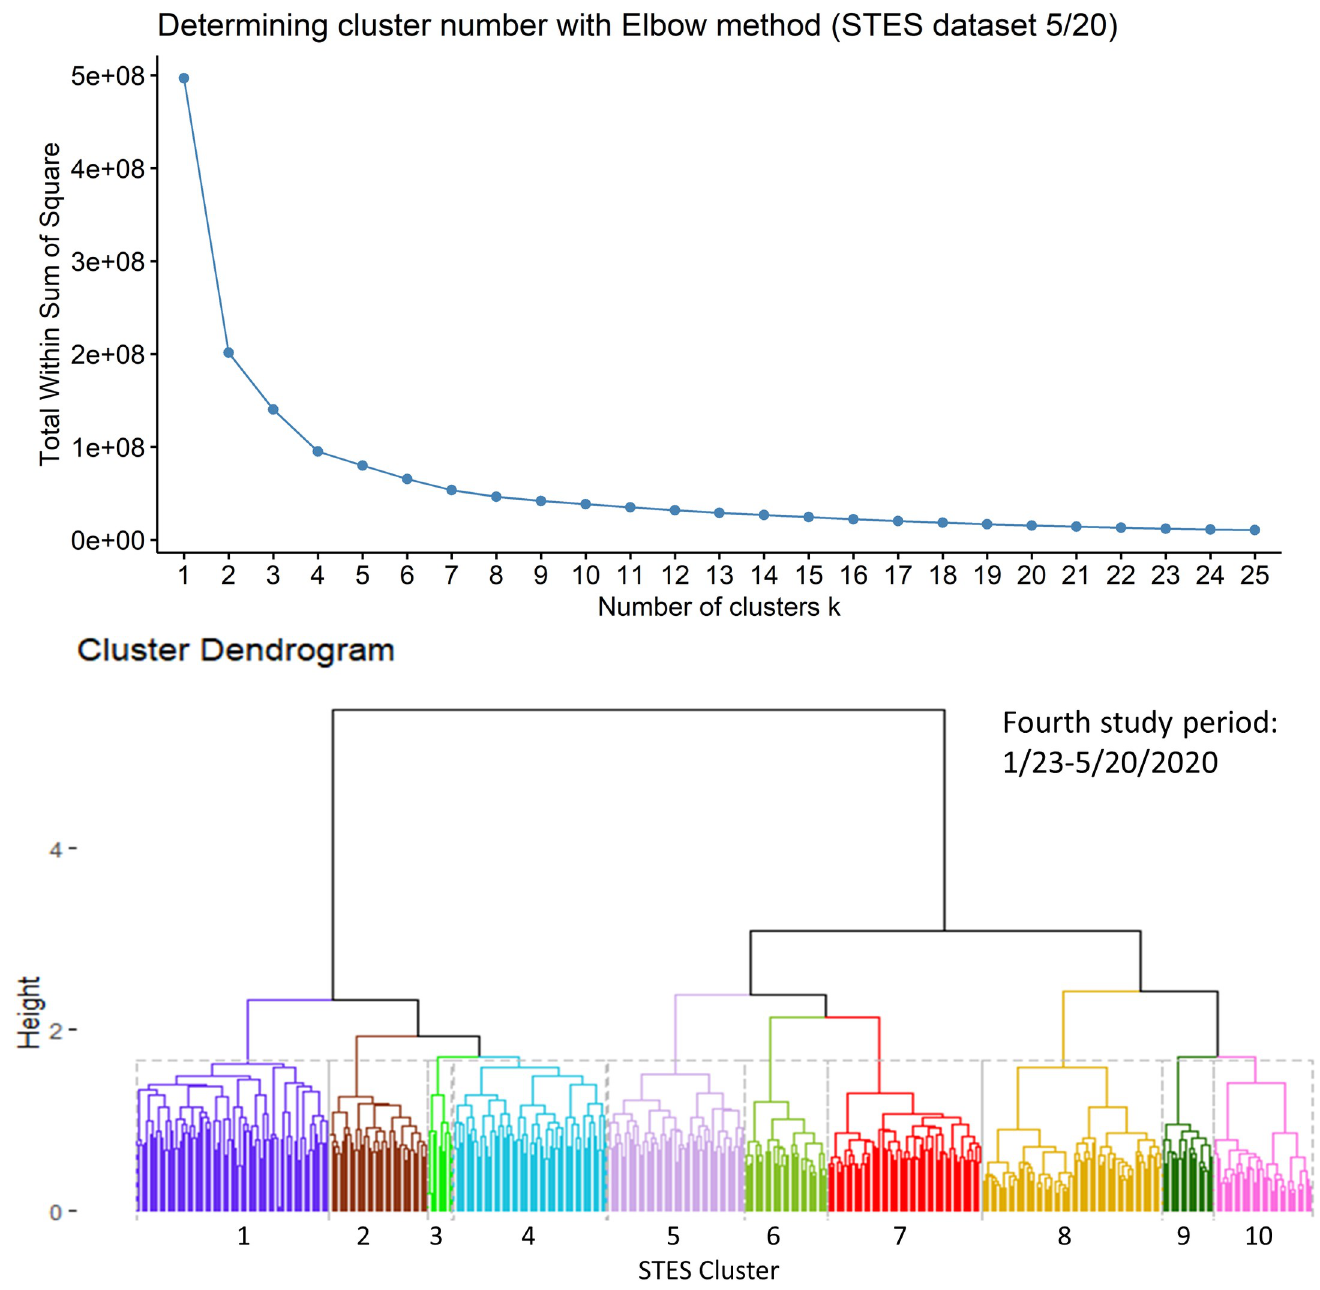
Fig 11. Elbow method evaluation and hierarchical clustering results for the 4 th period. Notice that the numberings and colors of STES clusters match with those of corresponding clusters on the map and the temporal trend graph in Fig 12.